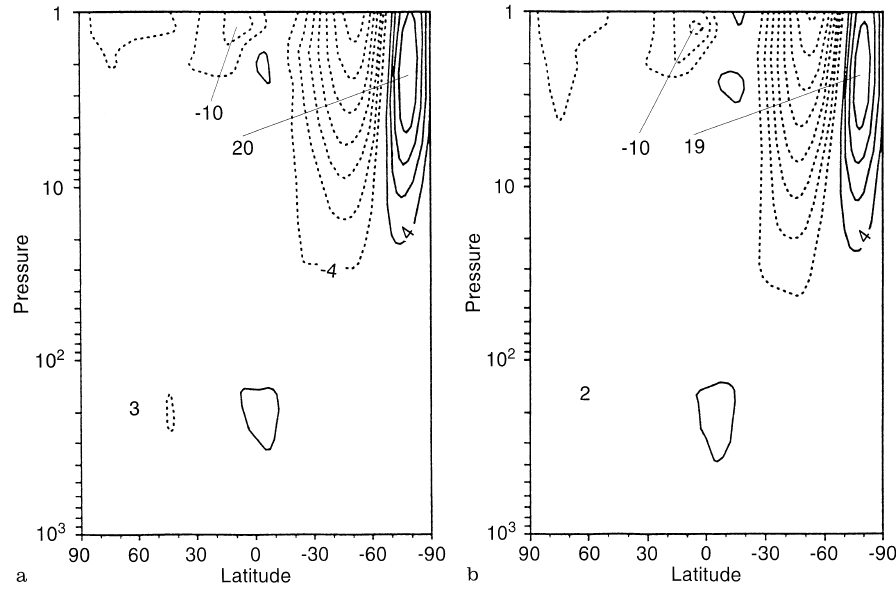
Fig. 7a, b. Zonal mean di(cid:128)erence of zonal wind in m s (cid:255) 1 for July, between a the experiments GWD41 and GWD31, and b the experiments GWDT41 and GWD31; contour interval 4 m s (cid:255) 1 and the dotted lines represent